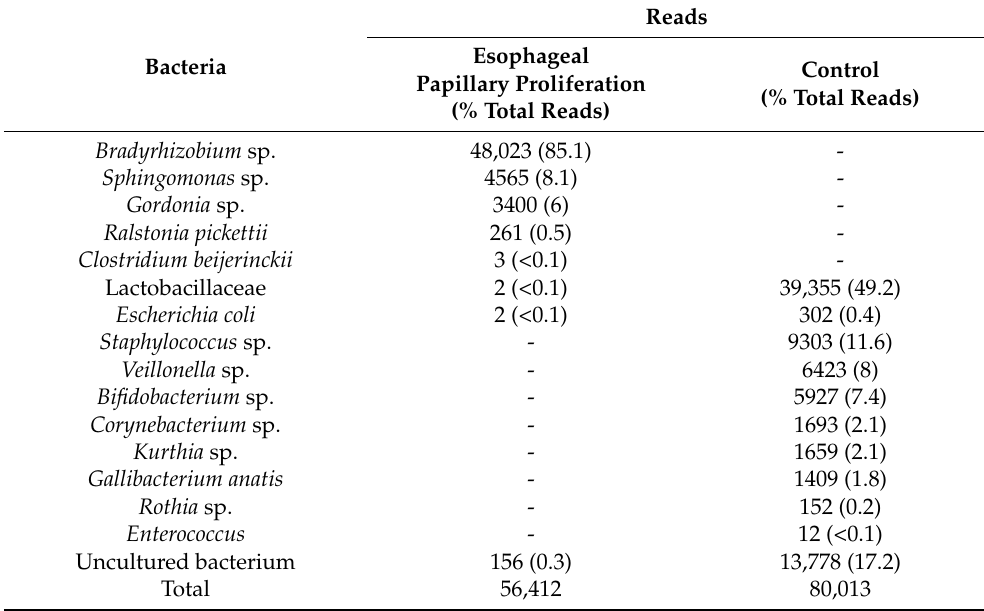
Table 1. Bacteria identified using the 16S-23S rRNA gene region with esophageal papillary prolifera- tion sample and